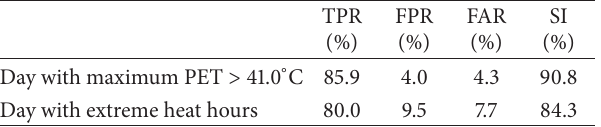
Table 4: Statistical indices for the evaluation of the forecasting ability of the developed ANN no. 1 forecasting model to predict the number of hours during the day when PET > 41.0 ∘ C (extreme heat stress). One day ahead prognosis. Warm period of